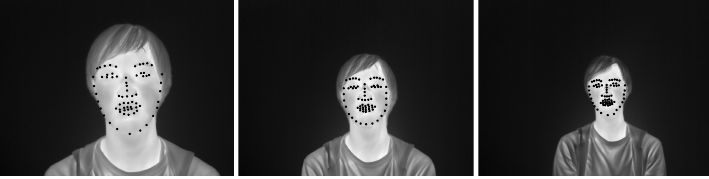
Figure 3. Examples of thermal infrared images acquired under three different distance conditions. From left to right: 60 cm, 90 cm, and 120 cm.